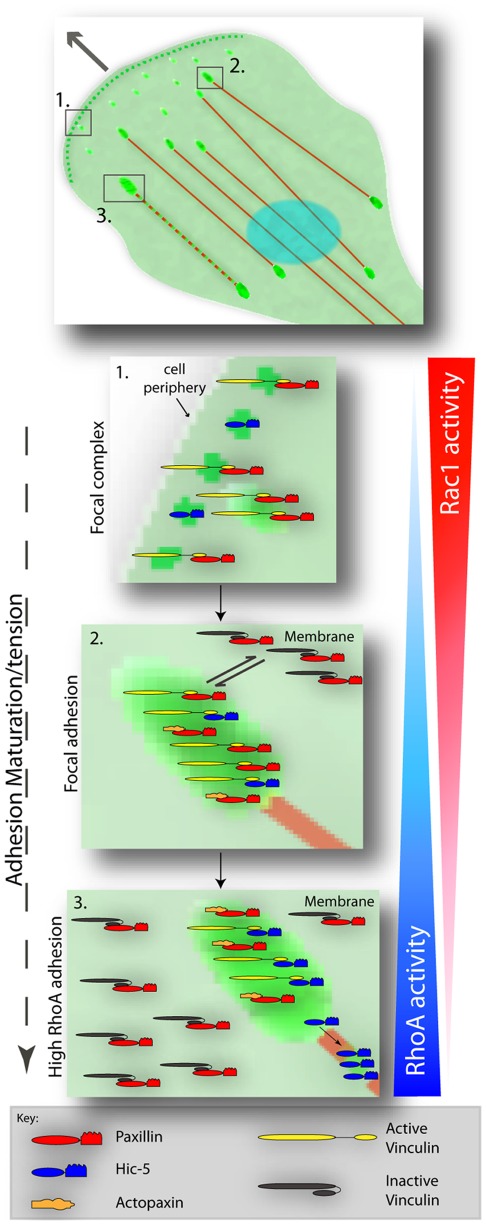
Schematic representation highlighting paxillin and Hic-5 molecular interactions during RhoGTPase-dependent adhesion maturation.(1) At the leading edge of a migrating cell high Rac1 activity stimulates nascent adhesion formation in which the interaction of paxillin with vinculin in its active conformation is stimulated to promote adhesion stabilization and maturation. (2) As adhesion contacts mature the levels of Rac1 and RhoA likely balance and an equilibrium is reached and a steady state maintained whereby paxillin, and to a lesser extent Hic-5, is interacting with active vinculin in adhesions. Furthermore, at steady state paxillin is also in a complex with vinculin in its inactive state in the membrane. (3) Elevated levels of RhoA activity as is observed in cells under tension induces the loss of paxillin-vinculin interaction and a distinct switch to paxillin binding to actopaxin, which likely stabilizes the complex in adhesions. An increase in RhoA and concomitant decrease in Rac1 activity promotes the direct interaction of Hic-5 with active vinculin in contractile adhesions and stimulates the redistribution of Hic-5 to stress fibers to function potentially in adhesion strengthening and/or mechanosensing.